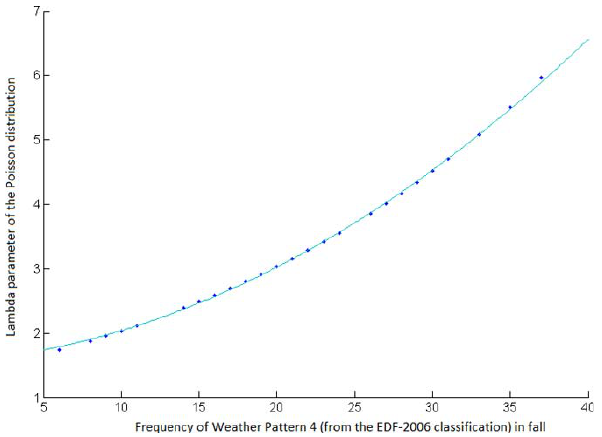
Fig. 5. Relationship between the scale parameter of the GP distri- bution and monthly temperature and sea level